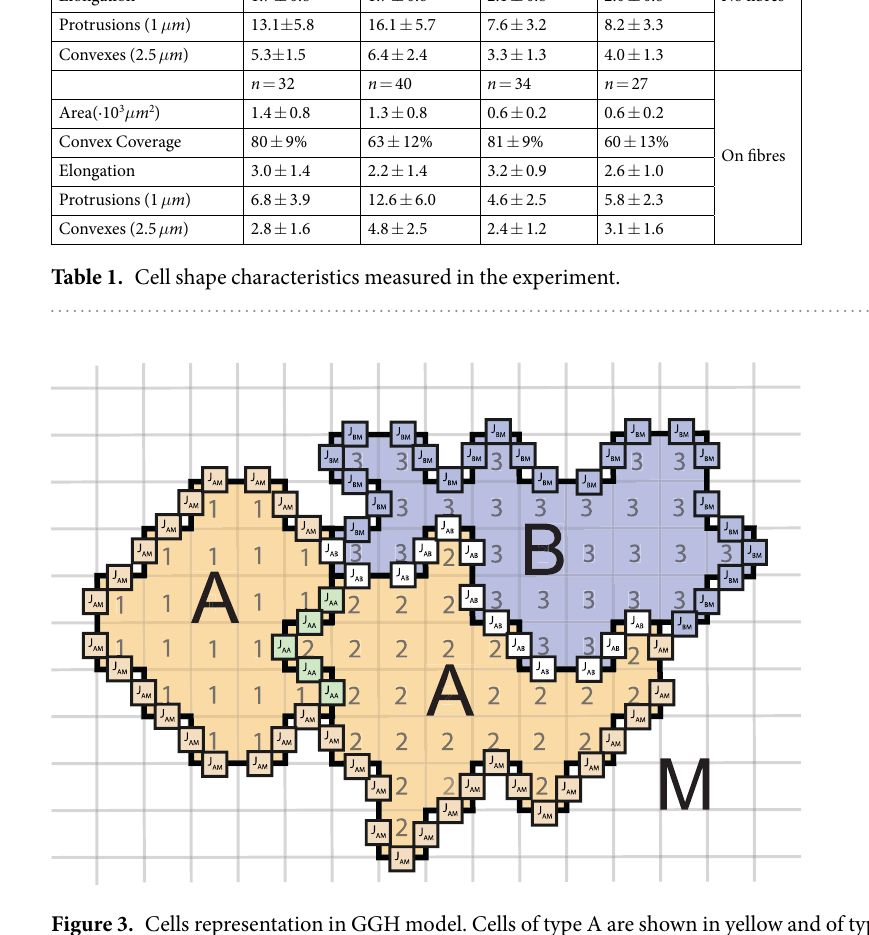
Figure 3. Cells representation in GGH model. Cells of type A are shown in yellow and of type B–in blue. Media around the cells is shown in white and denoted in the model with zero index. Cells interact via adhesion with the surface energy J. This energy depends on the cell types involved (shown in different colours and with different